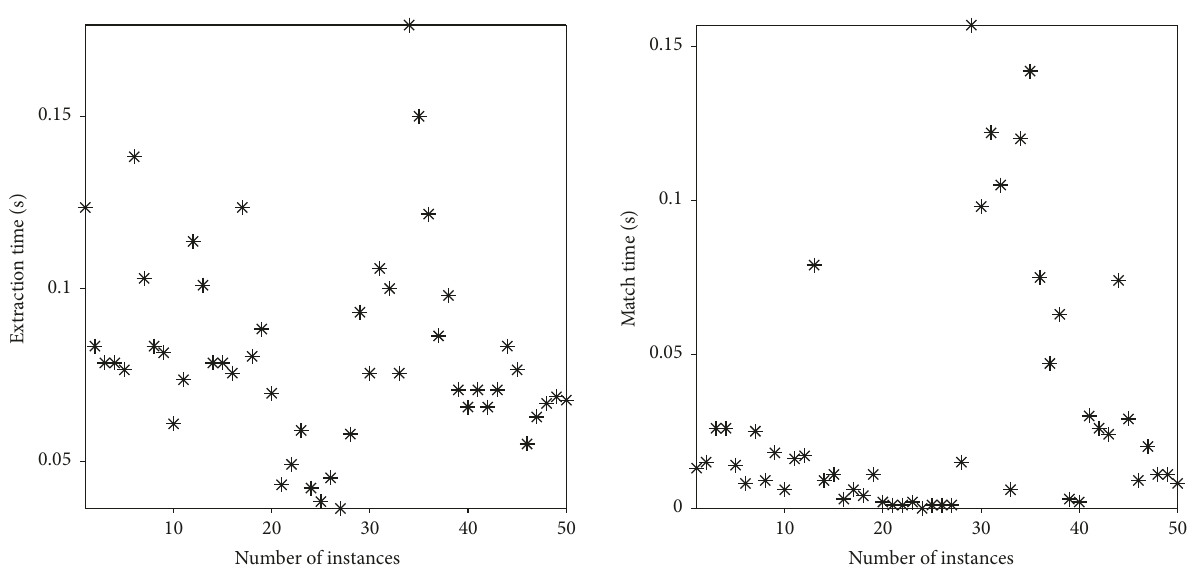
Figure 14: Time consumption for